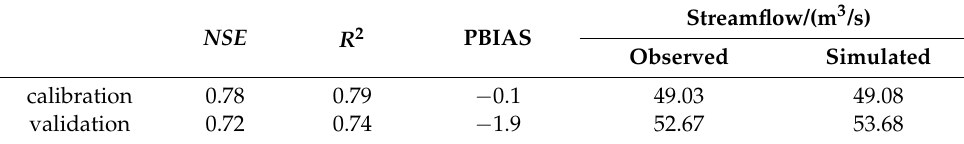
Table 3. Evaluation of monthly runoff simulation results of SWAT Model in Tahe River